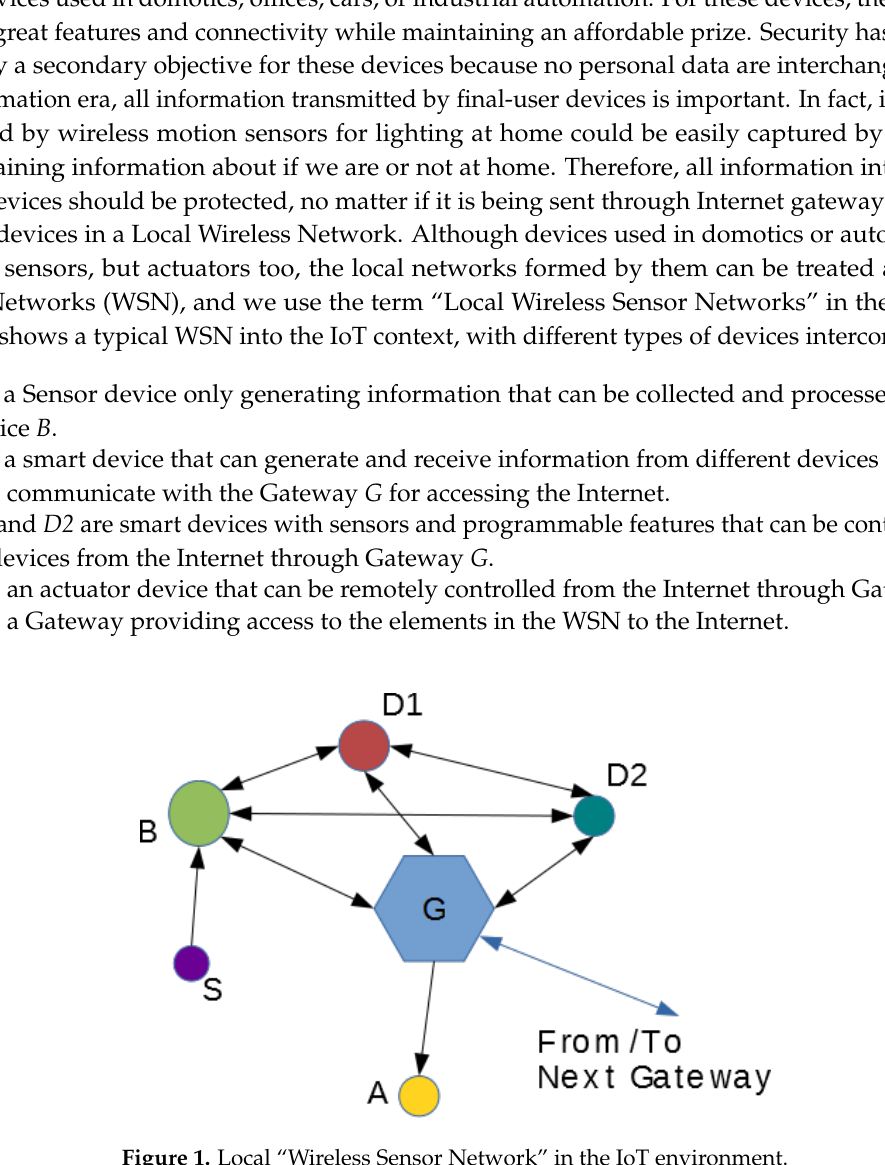
Figure 1. Local “Wireless Sensor Network” in the IoT